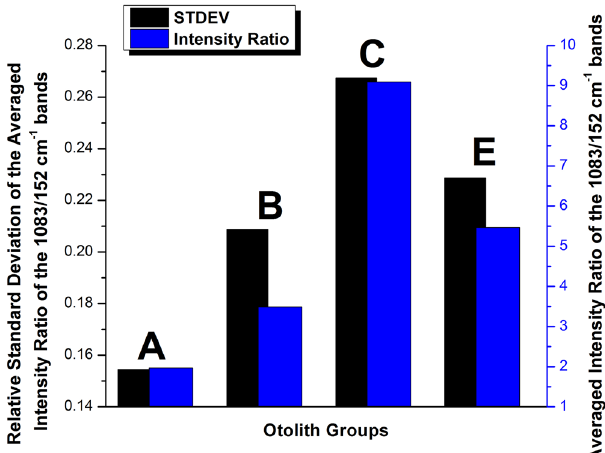
Figure 5. Relative Standard Deviation of the Intensity ratio of the 1083/152 cm –1 bands calculated for each otolith group. With blue, Group A, green Group B, red Group C and black Group E.